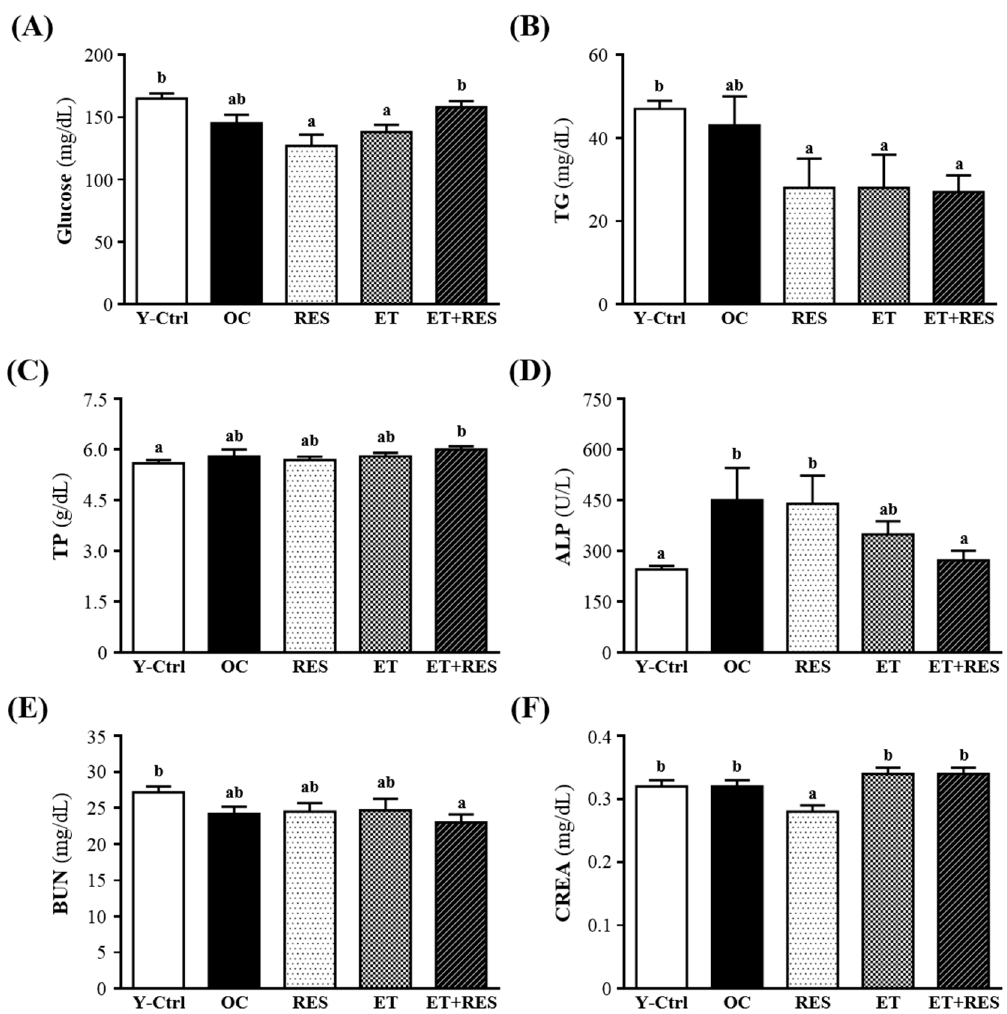
Figure 4. Effect of 4-week resveratrol (RES) supplementation and exercise training (ET) on biochemical assessments at rest, including ( A ) glucose, ( B ) triglyceride (TG), ( C ) total protein (TP), ( D ) alkaline phosphatase (ALP), ( E ) blood urea nitrogen (BUN), and ( F ) creatinine (CREA) levels in serum. Mice were pretreated with the vehicle, RES, ET, and ET+RES for 28 days. Data are the mean ± SEM. Different letters indicate a significant difference at p < 0.05 according to a one-way ANOVA. Y-Ctrl, a young control group; OC, an older control; RES, a supplementation with RES group; ET, a ET group; ET+RES, a combination of ET and RES supplementation group.